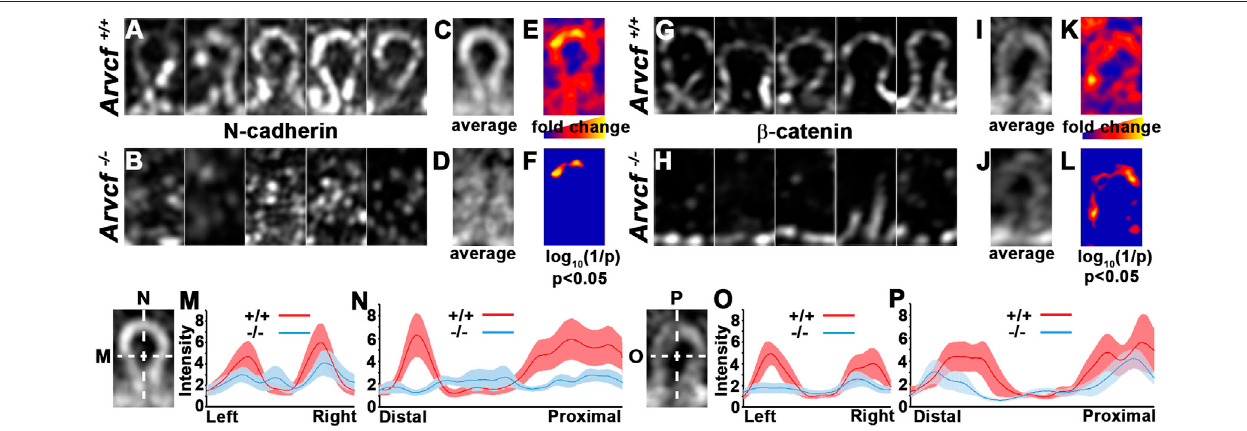
FIGURE 7 | Arvcf is required for N-cadherin/ β -catenin localization within interlocking protrusions. (A – L) Representative individual images of similarly sized, interlocking protrusions from Arvcf +/+ (A,G) and Arvcf − / − (B,H) lenses immuno fl uorescently labeled with N-cadherin (A – B) or β -catenin (G – H) were aligned and used to measure the fl uorescent intensity of each pixel. The mean intensity for each pixel was calculated and used to generate an arti fi cial image that represents the average signal intensity for N-cadherin (C – D) or β -catenin (I – J) in Arvcf +/+ (C,I) and Arvcf − / − (D,J) fi ber cell interlocking protrusion. (E,K) represent an arti fi cial image where thefoldchangeateachpixelpositionisindicatedbyaheatmap.Regionswhere Arvcf +/+ interlockingprotrusionshavemoresignalthan Arvcf − / − protrusionshavewarmer (redder) colors and regions where differences are less pronounced have cooler colors (bluer). (F,L) represent an arti fi cial image indicating where statistically signi fi cant differencesinpixelintensityarelocated.Notethatthetipsofinterlockingprotrusionshavethegreatestandstatisticallysigni fi cantdifferences( p < 0.05). (M – P) Themean intensity and standard error of pixels from individual interlocking protrusion images along the lines drawn parallel to the distal-proximal or left-right axes from each experimentalgroup aredepicted inthegraphs.Note thedepressed N-cadherin and β -catenin intensityalongbothaxes Arvcf − / − protrusions. Allimages weretakenwith a Plan-Apochromat ×63/1.40 oil objective and a Zeiss Airyscan equipped microscope was utilized.